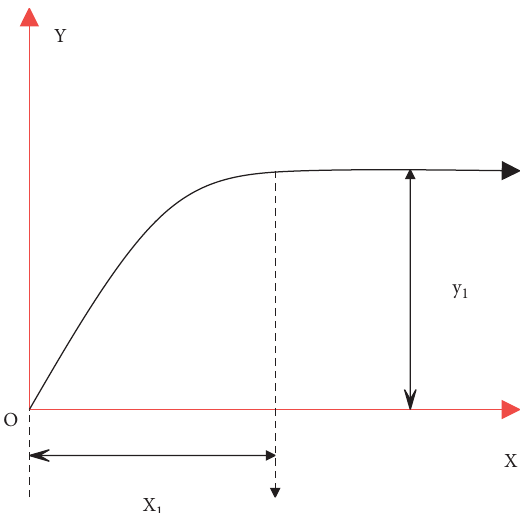
Figure 1: Image of the route planning method based on the sine function model.